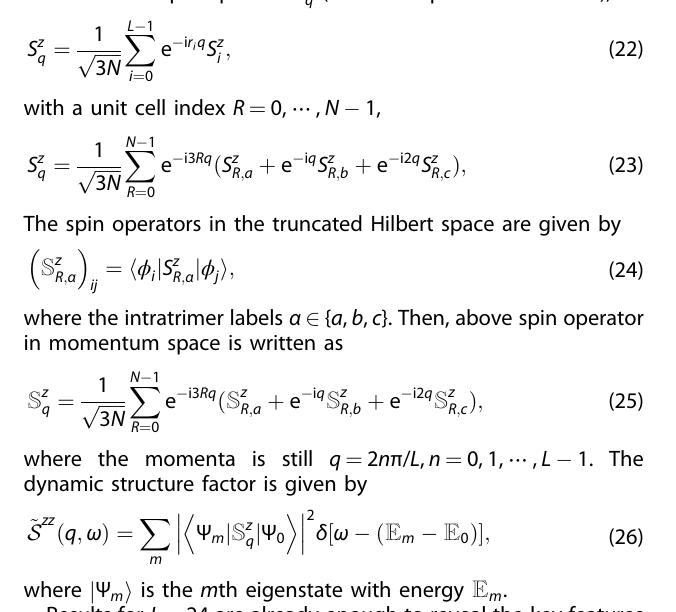
ground states with M = 0 (cid:6) (cid:12) N (cid:6) .